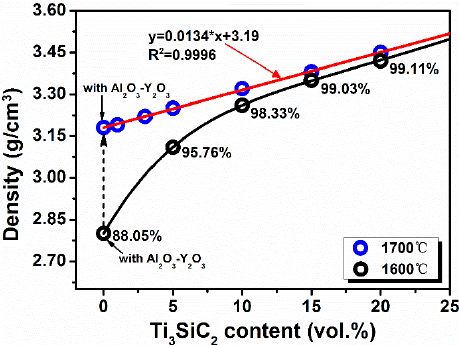
Figure 1. Density of Si 3 N 4 ceramics as a function of Ti 3 SiC 2 content.